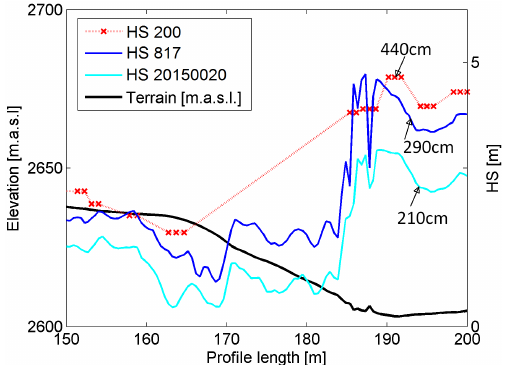
Figure 14. Snow depth profile 1 along the crown fracture of avalanche no. 200 for snow distributions of avalanches no. 200, no. 817 and no. 20150020 at the area separating CB1 from CB2. The numbers indicate the corresponding snow depth measured at the weather station. It is important to note that measurements along the crown fracture of avalanche no. 200 only exist for data points; at the line in between data points, no measurements are